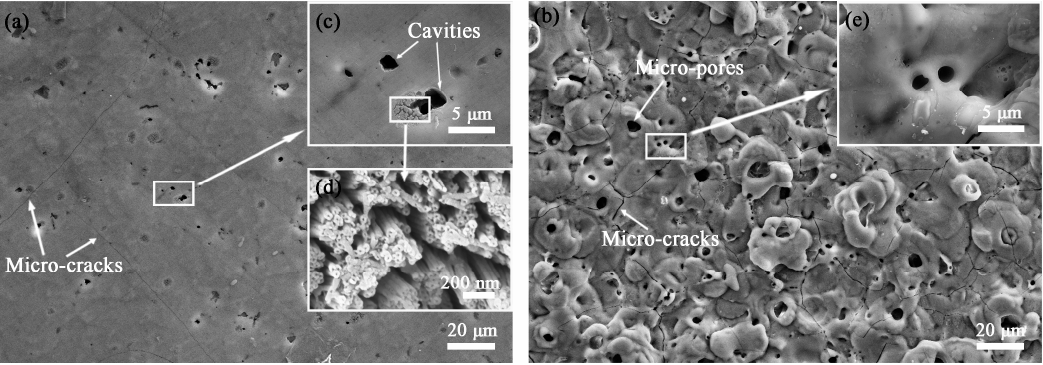
Figure 1. Surface scanning electron microscope (SEM) micrographs of the HA coating ( a , c , d ) and the MAO coating ( b , e ) on the 7050 Al alloy.